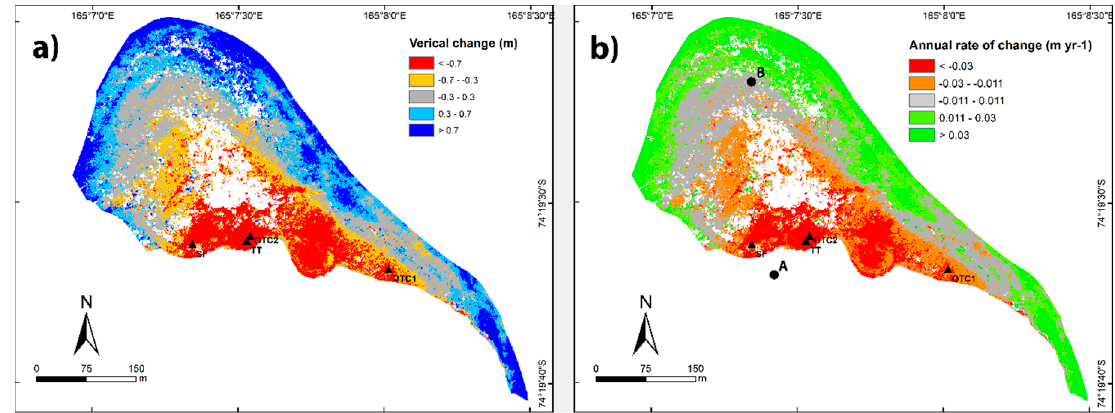
Figure 9. ( a ) Vertical change (m) occurred from 1993 to 2019, ( b ) average annual rate of vertical change (m yr − 1 ) from 1993 to 2019. White areas correspond to “no data” due to 3D reconstruction poor matching, while gray areas correspond to vertical changes or rate within the limit of detection of the clouds operation. “A” and “B” indicate the starting and ending point of the ERT showed in the Section 4.3.